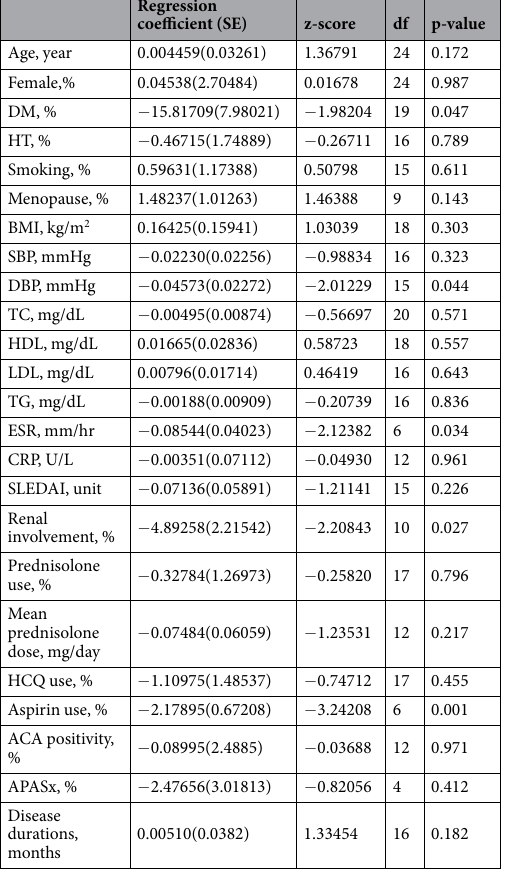
Table 3. Mixed-model meta-regression analysis of potential moderators of difference in brachial artery endothelium-dependent flow-mediated dilation. Abbreviations: SE, standard error; df , degree of freedom; DM, diabetes mellitus; HT, hypertension; BMI, body mass index; SBP, systolic blood pressure; DBP, diastolic blood pressure;TC, total cholesterol; HDL, high density lipoprotein; LDL, low density lipoprotein; TG, total triglyceride; ESR, erythrocyte sedimentation rate; CRP, C-reactive protein; SLEDAI, Systemic Lupus Erythematosus Disease Activity Index; HCQ, hydroxychloroquine; ACA, anti-cardiolipin antibodies; APASx, antiphospholipid antibody